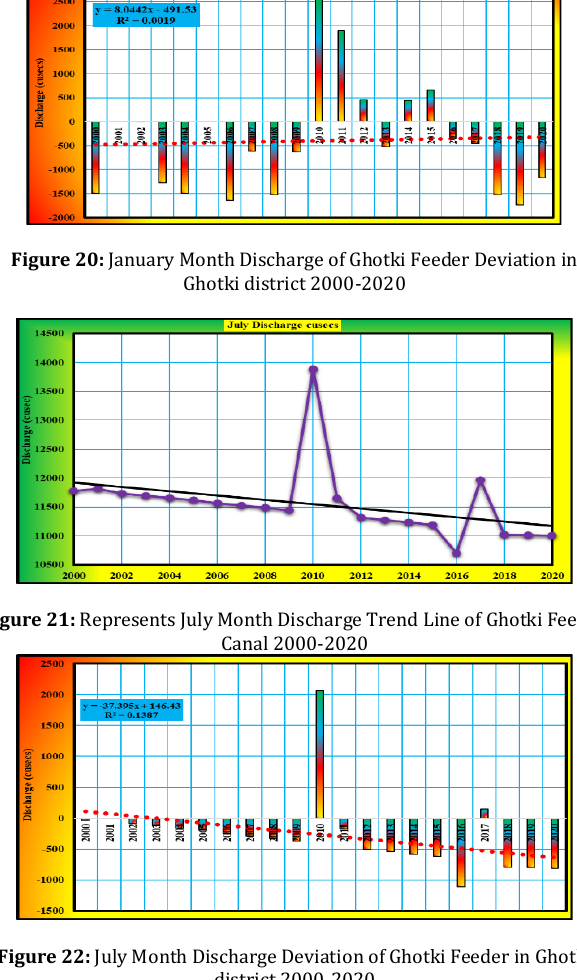
Figure 22: July Month Discharge Deviation of Ghotki Feeder in Ghotki district